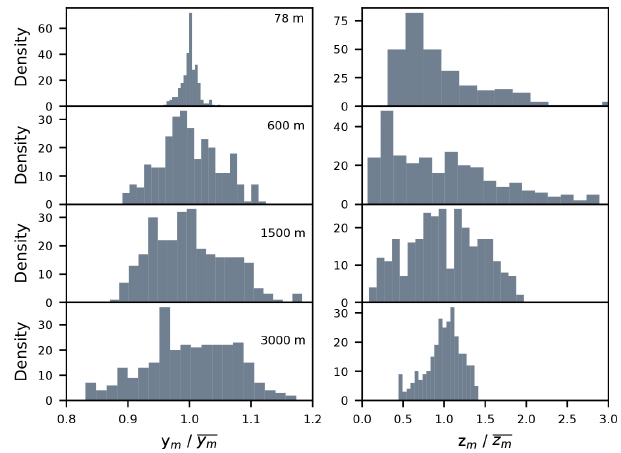
Figure 8. Top view of vertically integrated (a) instantaneous and (b) time-averaged plumes. Horizontally integrated (c) instan- taneous and (d) time-averaged plume. Also shown in panel (d) are mean plume centerline position (solid red line) and position of the maximum of concentrations (dotted red line). x ∗ is the normalized distance from the source as defined in Eq. (8).